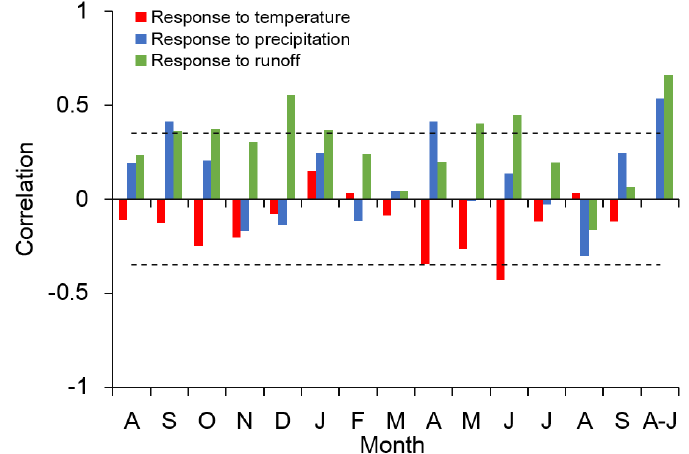
Figure 3. Correlation coefficients between radial growth of spruce trees and total monthly precipitation monthly mean temperature, and monthly mean runoff in the Kaiken River. Correlations are computed from the previous August to current September over 1983–2013. Dashed lines indicate the 95% confidence level.